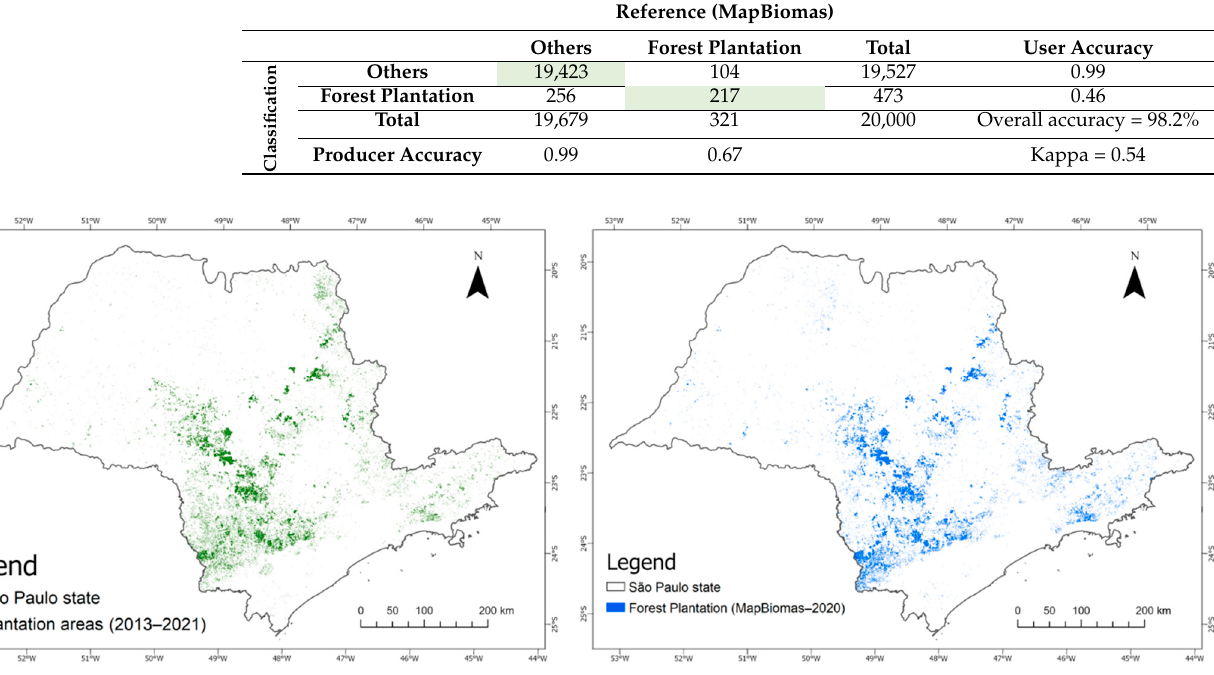
Figure 8. Forest plantation areas obtained by the proposed method ( left side) and forest plantation areas extracted from the MapBiomas product ( right side) for 2020. Table 4. Confusion matrix for the forest plantation classification in 2020.